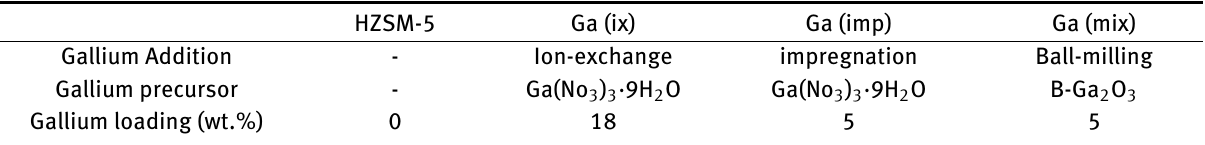
Table 2: Aromatic selectivities at 550oC for 1-hexene aromatiza- tion [45]